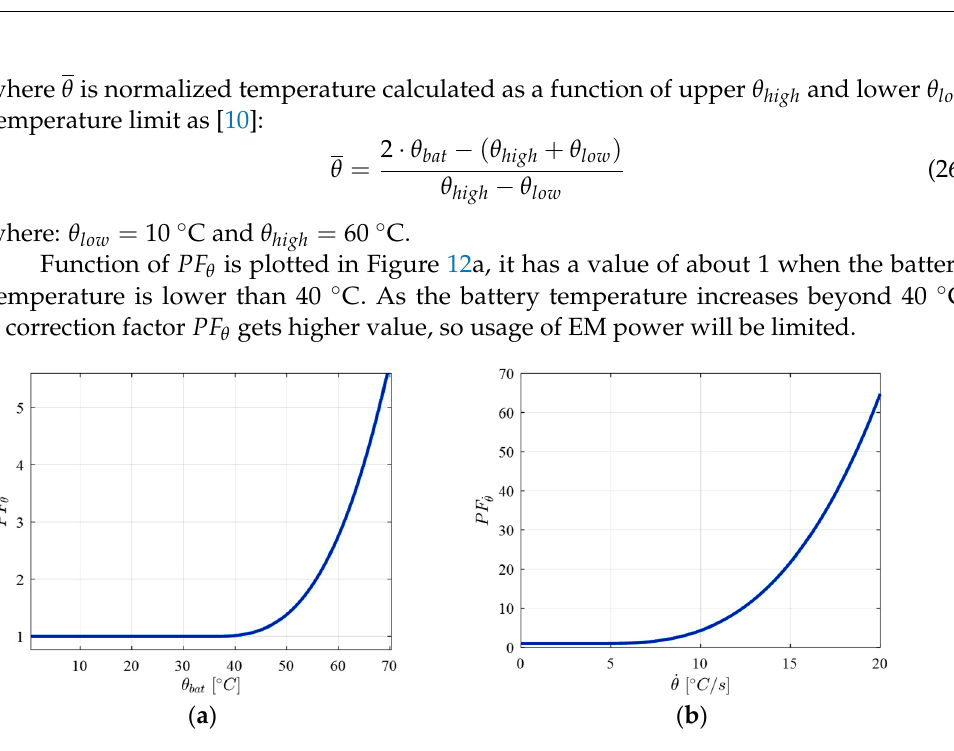
Figure 12. Penalty functions on temperature ( a ) and on temperature change rate ( b ).